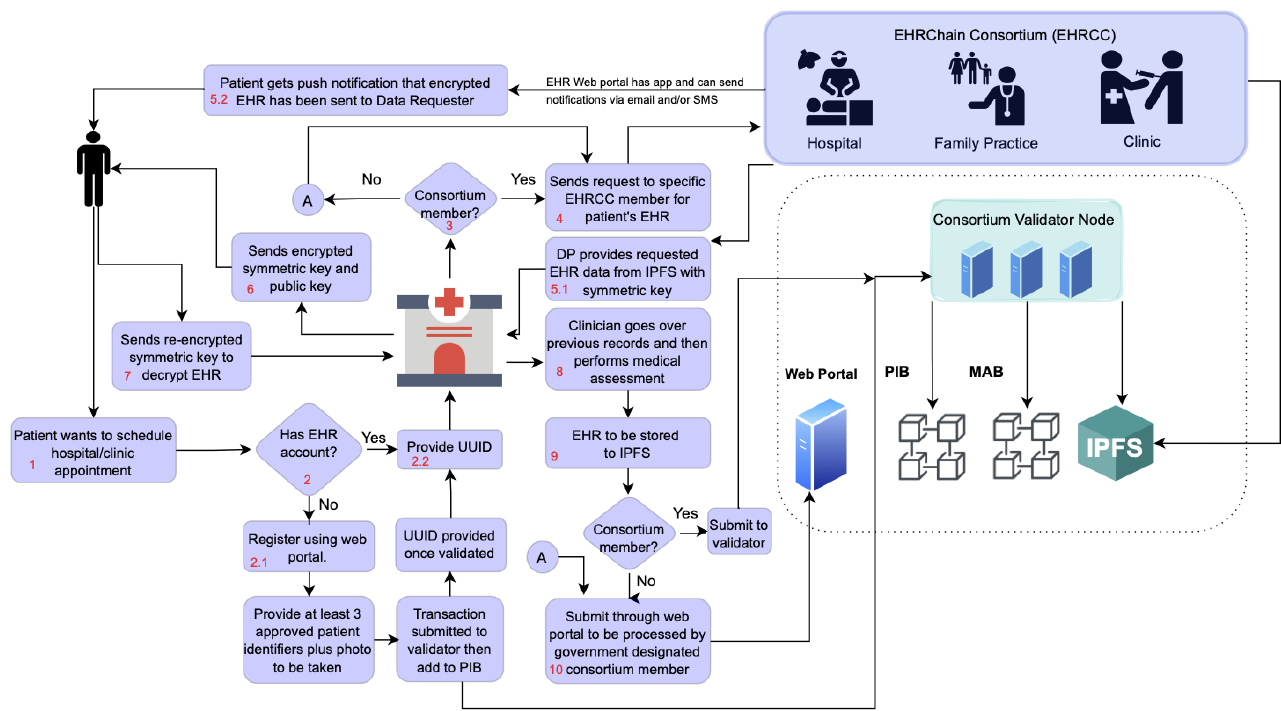
Figure 9. Proposed EHRChain system workflow.